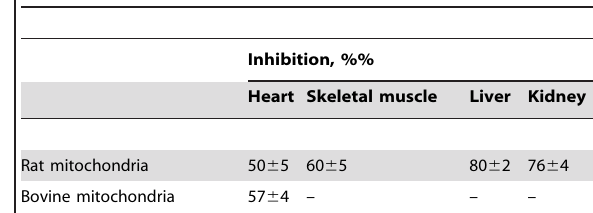
Table 1. Inhibition of the mitochondrial cytochrome c oxidase activity by Ca 2 +